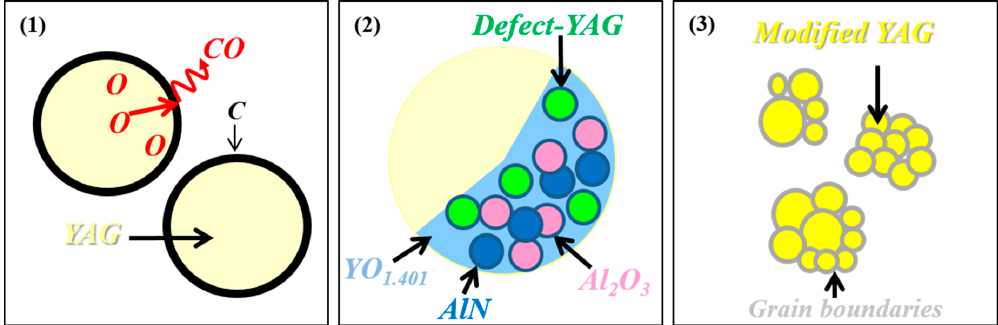
Figure 10. Schematic illustration of reaction process between C and YAG:Ce 3+ . ( 1 ) In the beginning, C reacts with YAG:Ce 3+ , which induces the formation of oxygen vacancies or induces carbothermal reduction and nitridation reactions; ( 2 ) Part of non-stoichiometric YAG starts to be decomposed into Y 2 O 3 , Al 2 O 3 and nitrided AlN, resulting in a distribution of various luminescent particles with different particle size in C@YAG:Ce 3+ -1500 ◦ C; ( 3 ) As increasing the heat-treatment temperature, the decomposition of YAG:Ce 3+ is enhanced, followed by the dissolution of formed YBO 3 and AlN/Al 2 O 3 , forming modified YAG:Ce 3+ sample with aggregated particles consisting of small grains of about 1 um size in C@YAG:Ce 3+ -1650 ◦